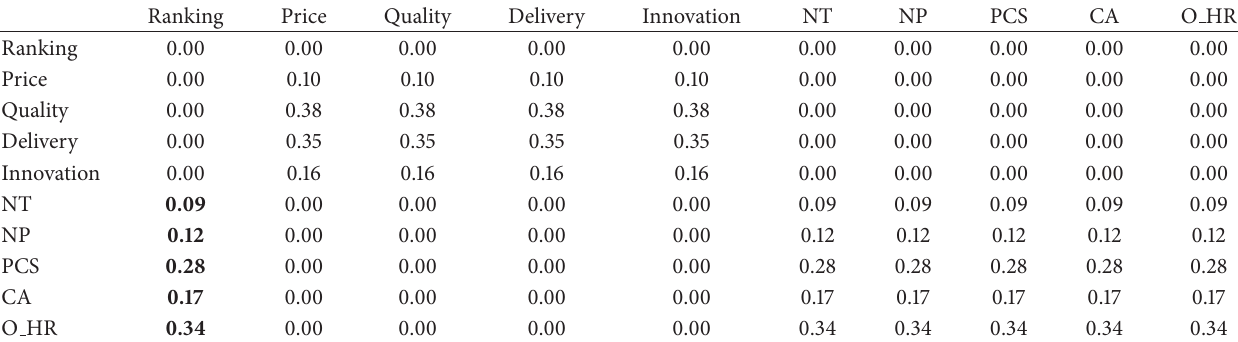
Table 12: Matrix limit corresponding to the decisions of decision agent